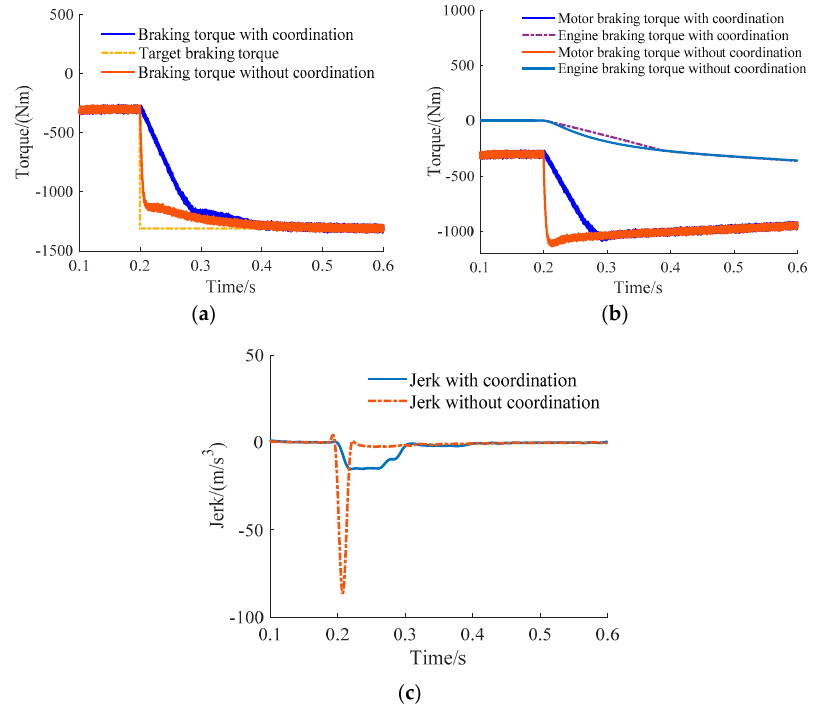
Figure 12. Simulation results of motor braking mode to motor and engine braking mode. ( a ) Total braking torque; ( b ) Motor and engine braking torque; ( c ) Vehicle jerk.